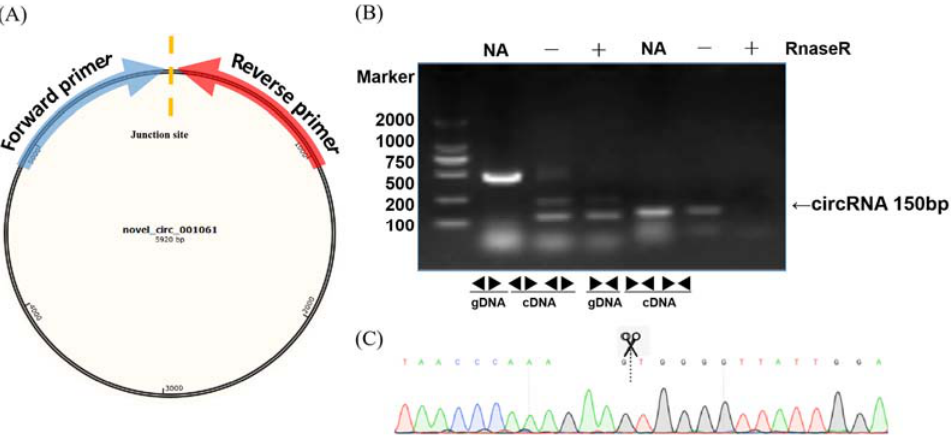
selected 20 circRNAs at different stages for qRT-PCR to validate the expression levels. The qRT-PCR results were mainly (17/20) consistent with the circRNA-seq data, indicating the high reliability of the RNA profiles (Figure S1).